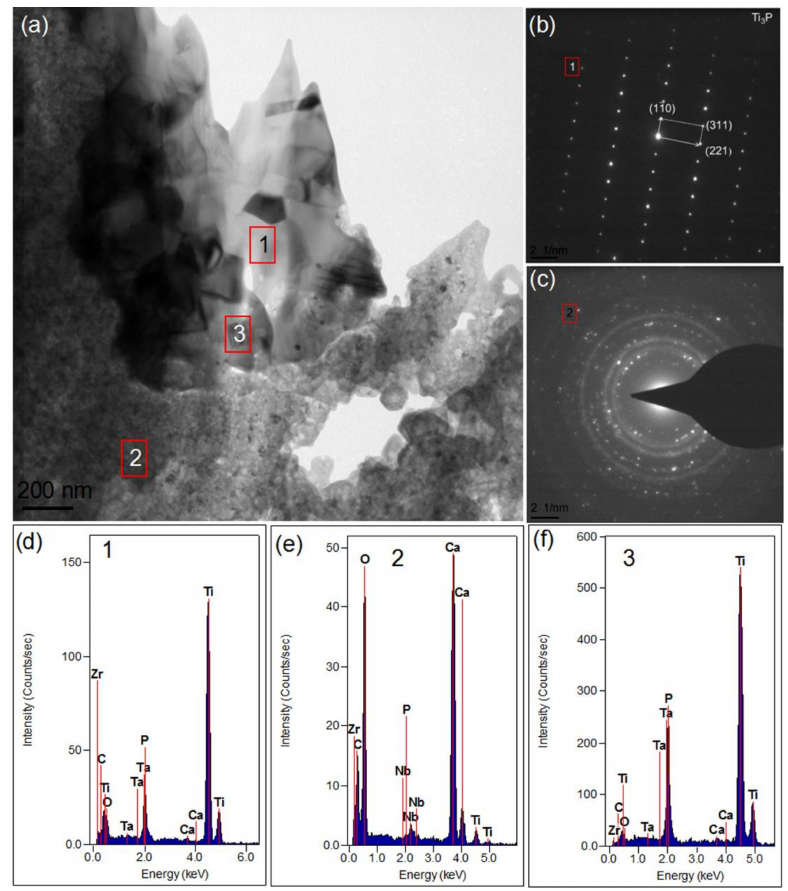
Figure 8. ( a ) TEM image of the 1.5-GNFs nanocomposite sintered at 1000 ◦ C; ( b , c ) the corresponding selected area diffraction (SAD) patterns of spots 1and 2; and ( d – f ) the corresponding EDS spectrums of spots